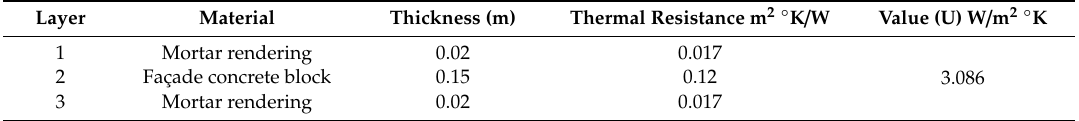
Table 2. Elements of the façade of a typical construction in the Dominican